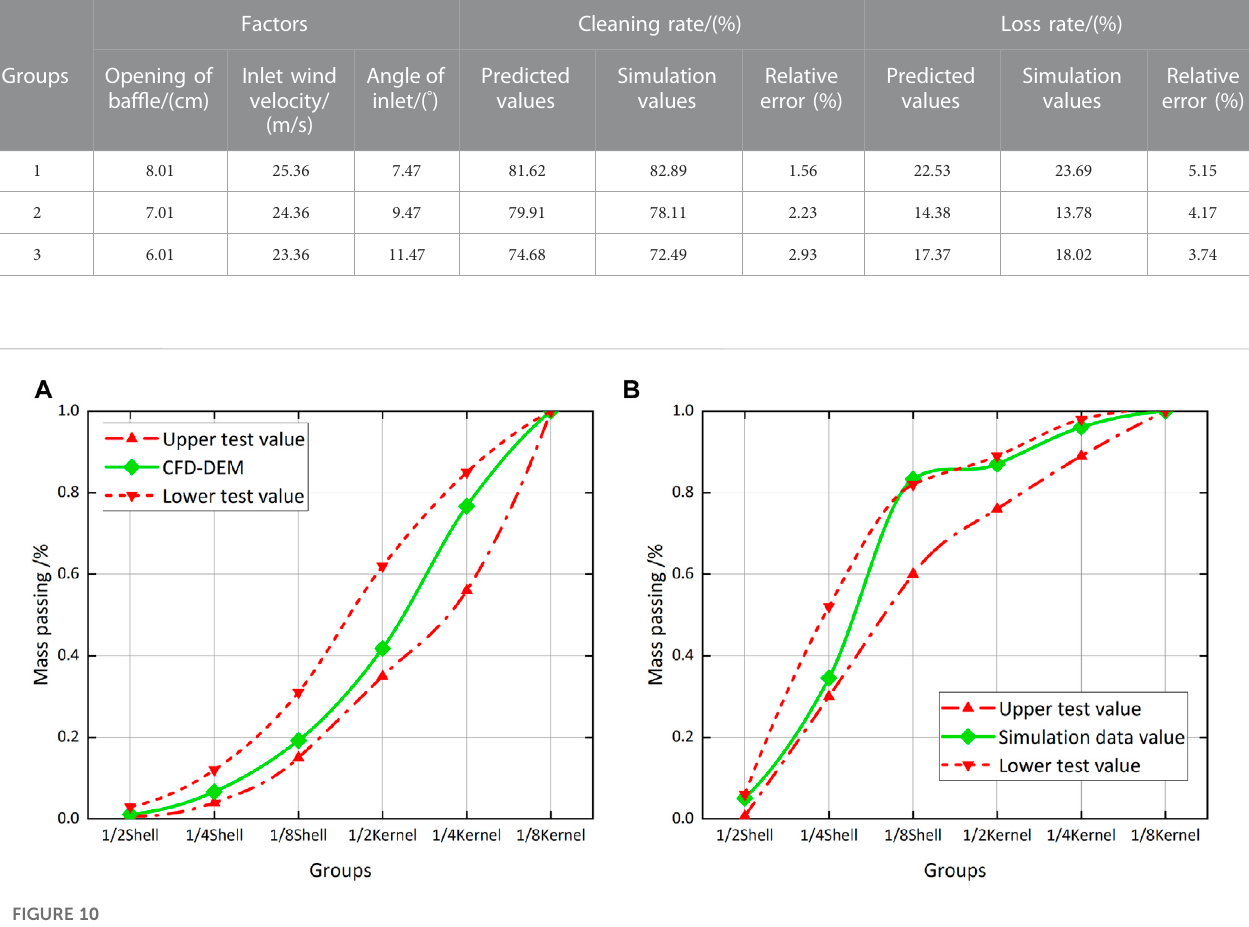
Figure 10. The dotted line represented the upper and lower limits of multiple test results. If the walnut simulation data (green solid line) is within the dotted line range, the simulation agrees with practical data.